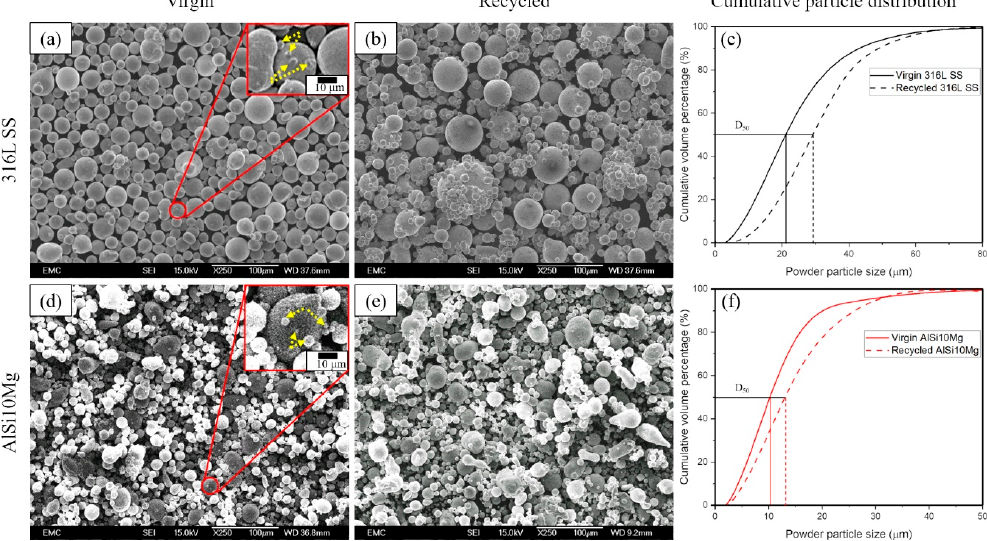
Figure 1. ( a ) Virgin, ( b ) recycled, and ( c ) cumulative particle size distribution of 316L SS powders; ( d ) virgin, ( e ) recycled, and ( f ) cumulative particle distribution of AlSi10Mg powders. Dashed arrows of the zoomed areas inset of ( a , d ) show satellites on the surface of the virgin powders.